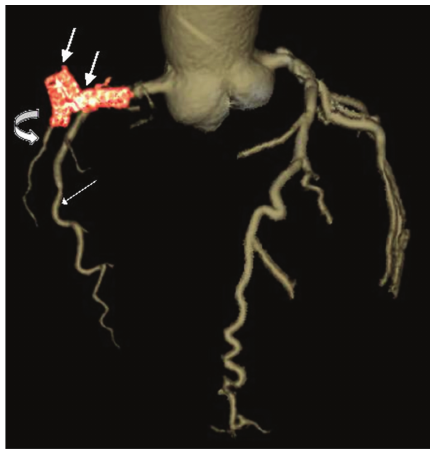
Figure 3: Volume-rendered image reveals RCA stent fracture at two levels (short thick arrows) with RCA perforation. Note opacified acute marginal branch of the RCA (long white arrow) and a faintly opacified poststent RCA (curved arrow).